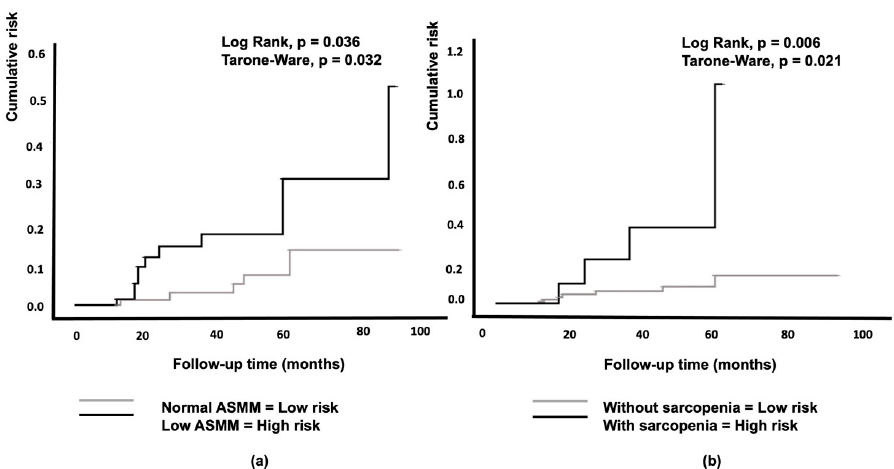
Figure 2. Kaplan–Meier curves for the cumulative risk of impaired fasting glucose/type 2 diabetes according to appendicular skeletal muscle mass ( a ) and the diagnosis of sarcopenia ( b ). ASMM, appendicular skeletal muscle mass.